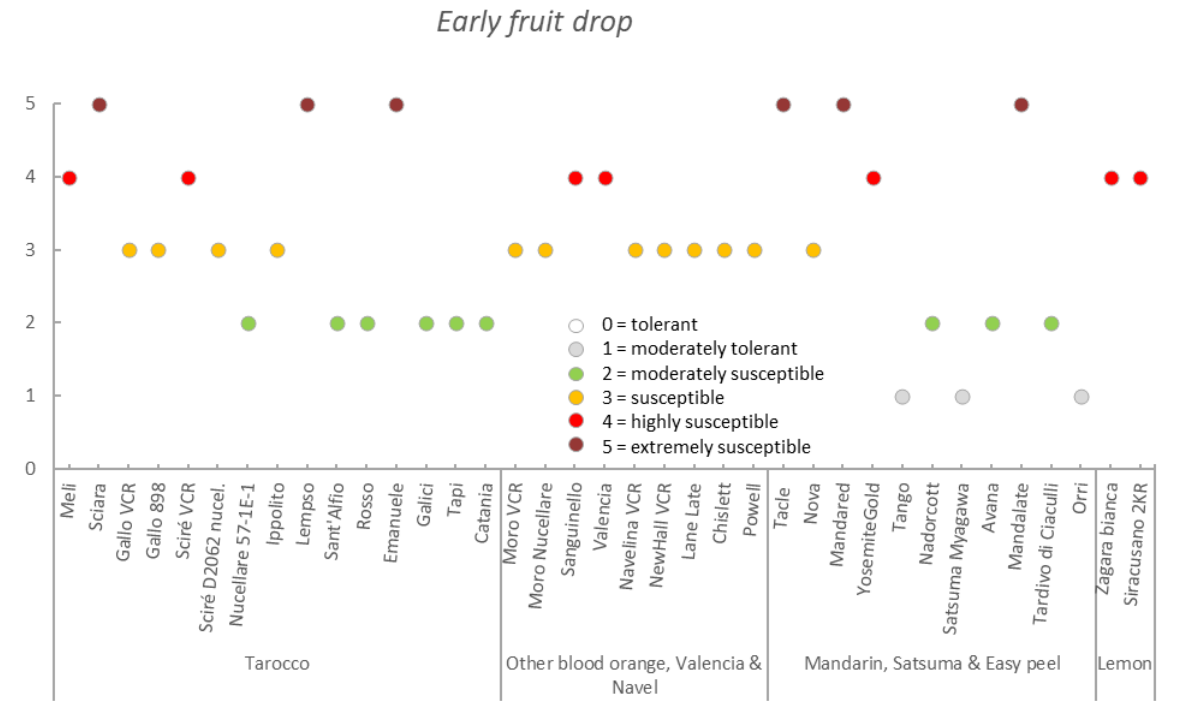
Figure 7. Maximum potential infection risk of early fruit drop recorded on detected Citrus germplasm. Data obtained from several Sicilian citrus production areas (from 1-to-20) within Citrus groups surveyed for three periods intercepting an eleven-year survey.